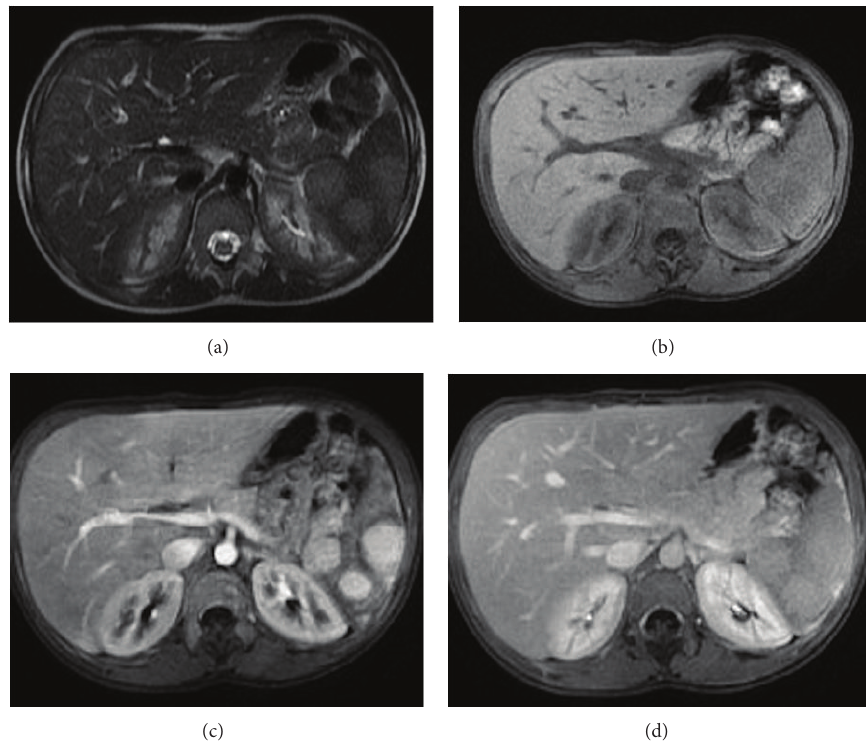
Figure 14: Splenic hamartoma. Axial T2wi SSFSE (a), pre- (b) and postcontrast axial T1w 3D-GRE with fat suppression in the arterial (c) and venous (d) phase. Multiple rounded lesions are seen on T2wi (a) and T1wi (b). These lesions demonstrate hyperenhancing characteristics on the arterial phase (c) progressing to isointensity on the venous phase